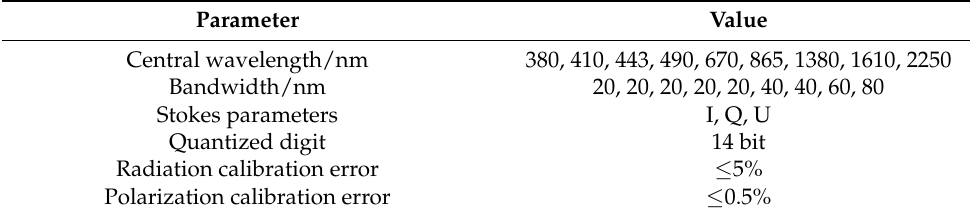
Table 1. The basic parameters of